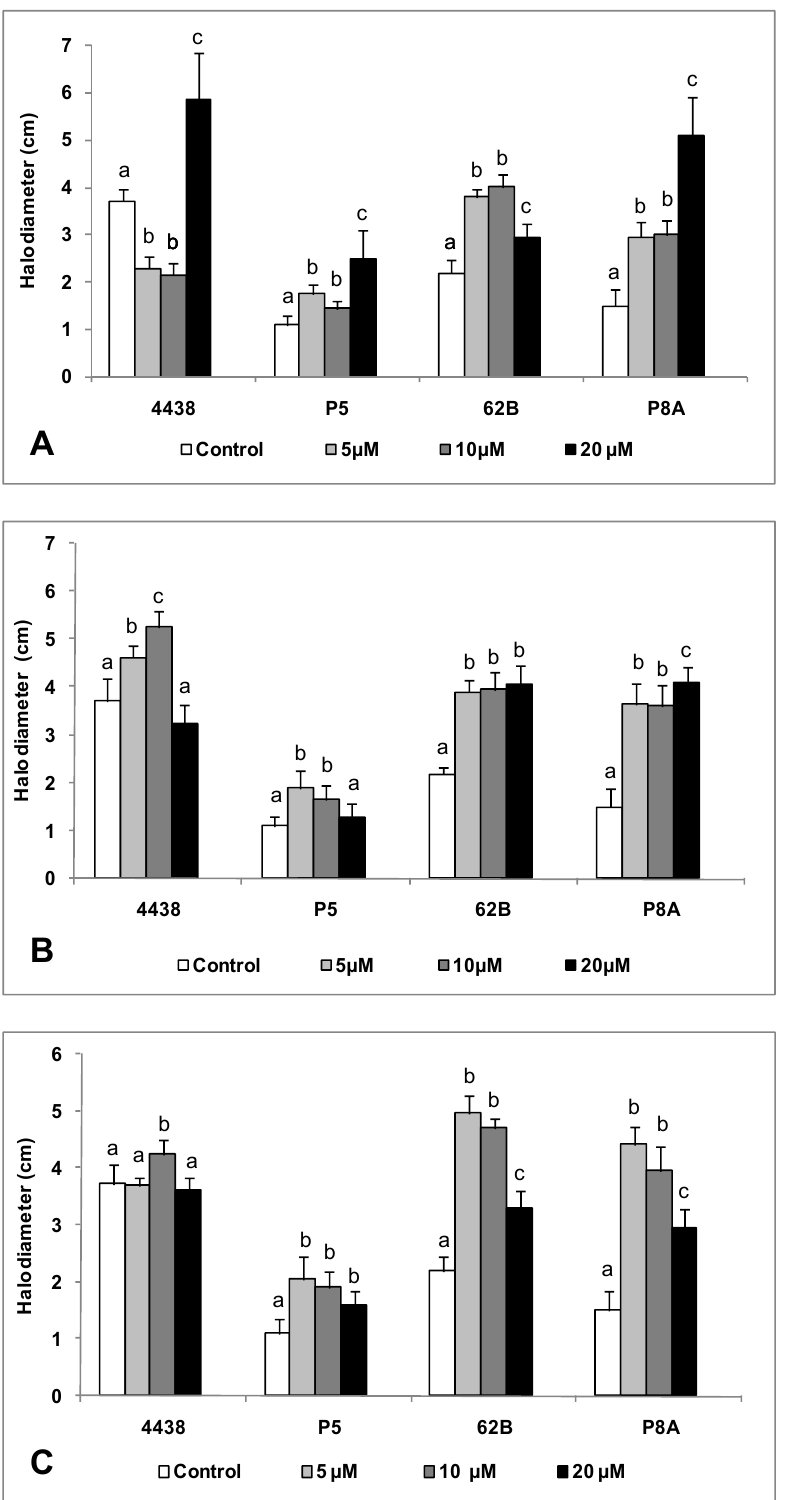
Figure 3. Effect of AHLs on swimming motility of peanut-nodulating